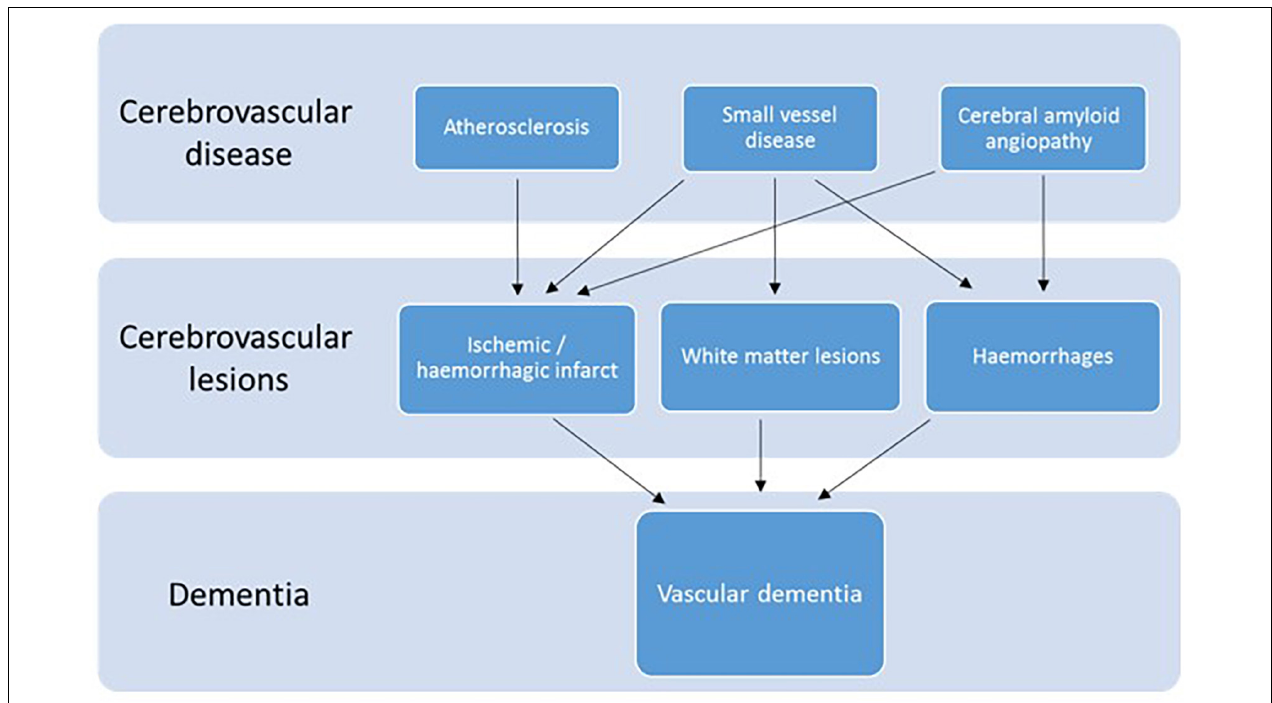
FIGURE 1 | Diagram of the cerebrovascular diseases and lesions that lead to VaD. Modified after (McAleese et al., 2016).